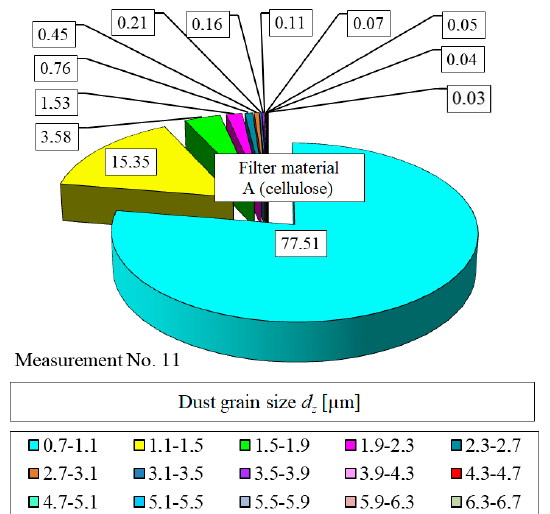
Figure 12. Particle size distribution in the air downstream of the filter element A after reaching the dust mass loading k mA = 110.7 g/m 2 (measurement no. 11).